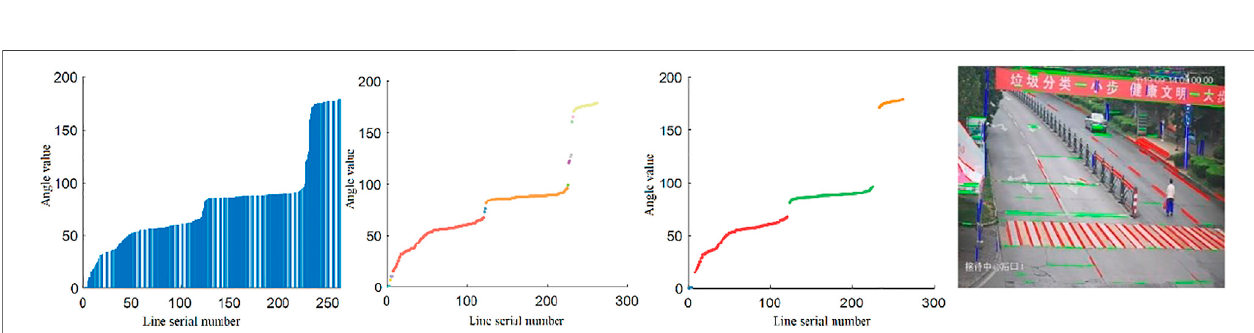
FIGURE 8 | Line screening